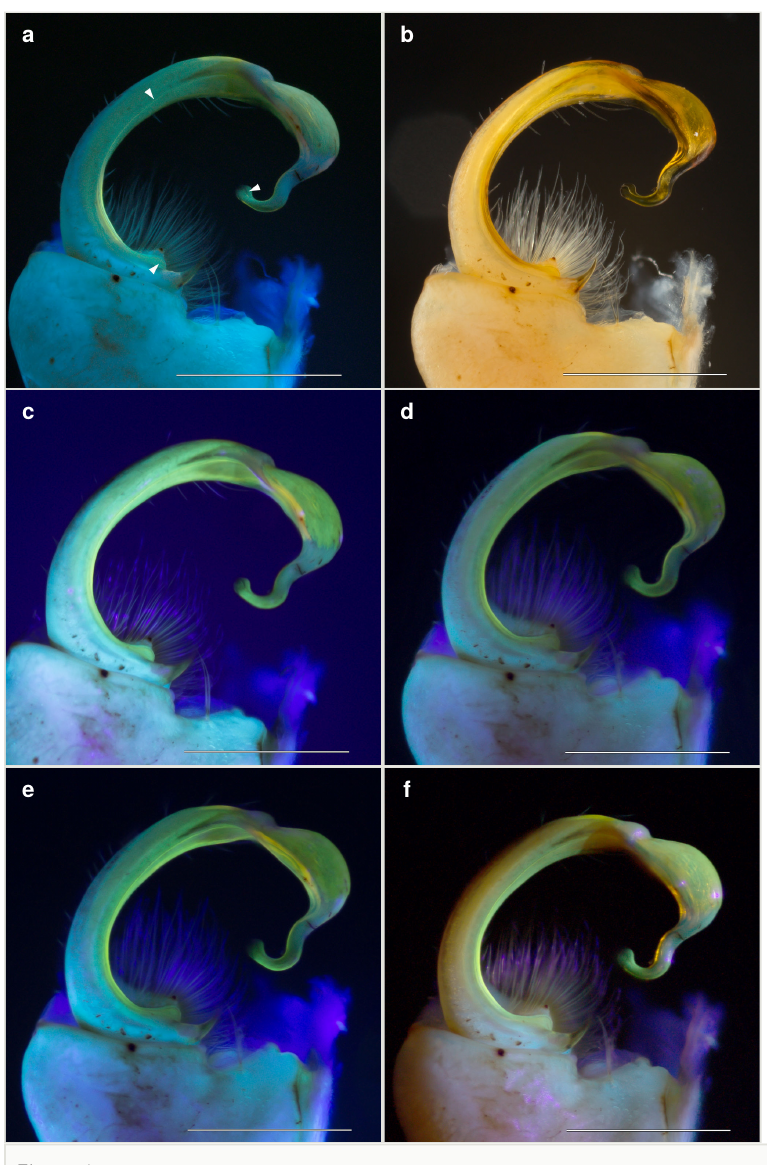
Figure 4. Images of the left gonopod from a male Brachoria sheari illuminated with di ff erent light sources. Scale bar = 1 mm. Prostatic sperm groove labeled with